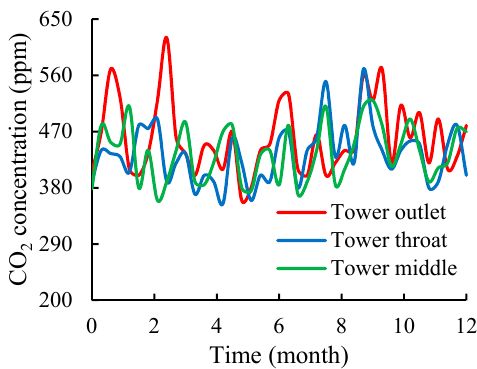
Figure 4. CO 2 concentration over a year in the cooling tower.